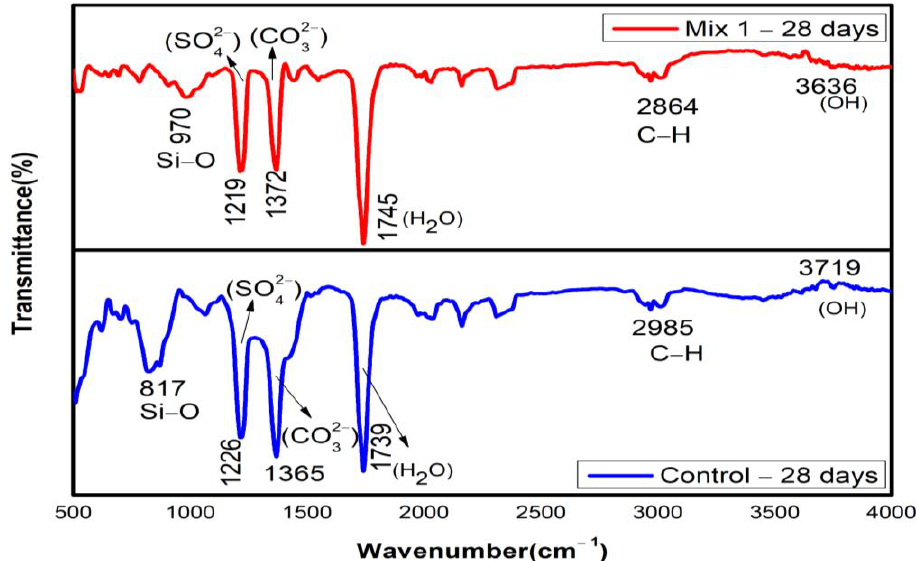
Figure 12. FTIR of 28-day hydrated samples (Mix 1 and Control).